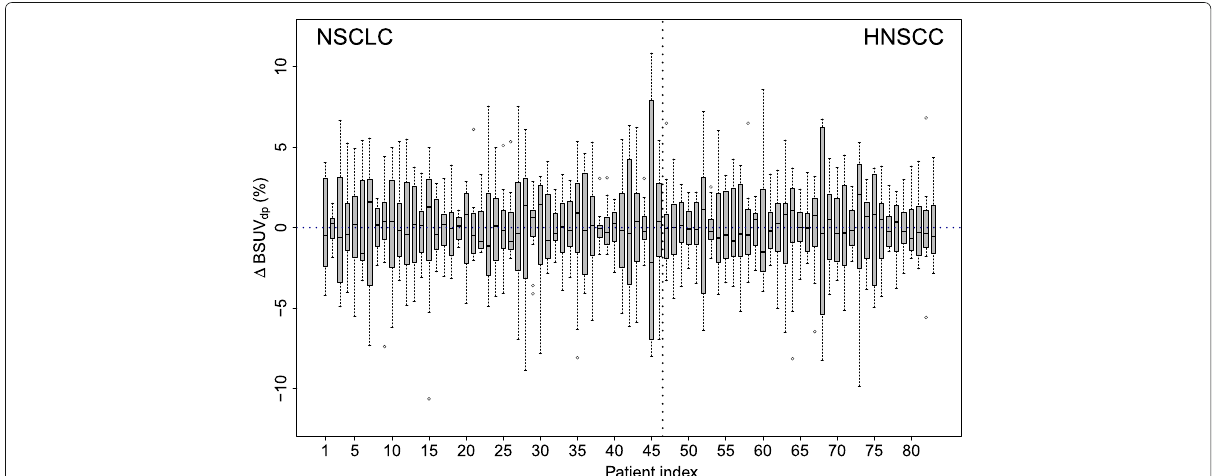
Fig. 3 Boxplot of fractional deviation from observer mean for the respective patient ( (cid:2) BSUV dp ), grouped by patient. Note the patient dependence of the magnitude of the interobserver variability